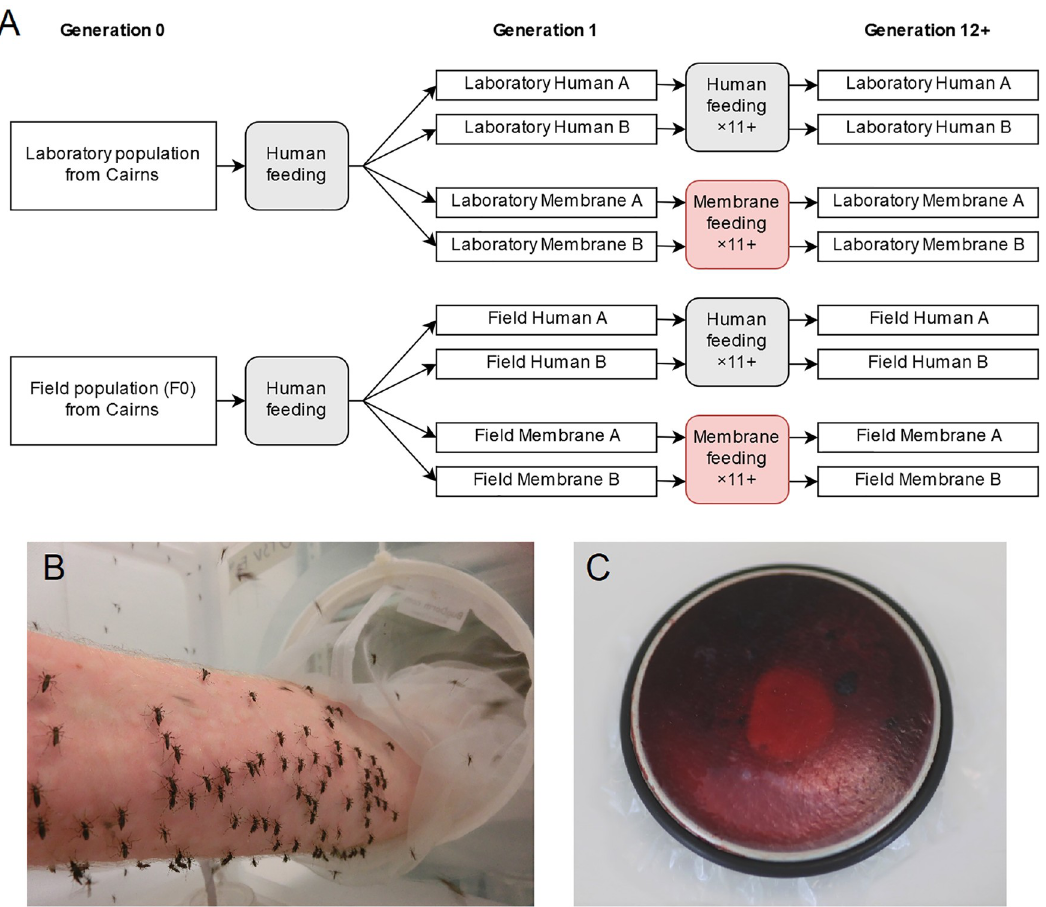
Fig 1. Establishment and selection of the laboratory and field Aedes aegypti populations for feeding on human arms or membrane feeders. (A) The eight populations underwent selection for at least 11 generations on each blood source before conducting experiments (except for the semi-field experiment). (B) Direct human arm blood feeding. (C) Completed membrane feeding apparatus, showing a blood-filled reservoir covered with a collagen membrane and sealed by a rubber ring (image credit: Veronique